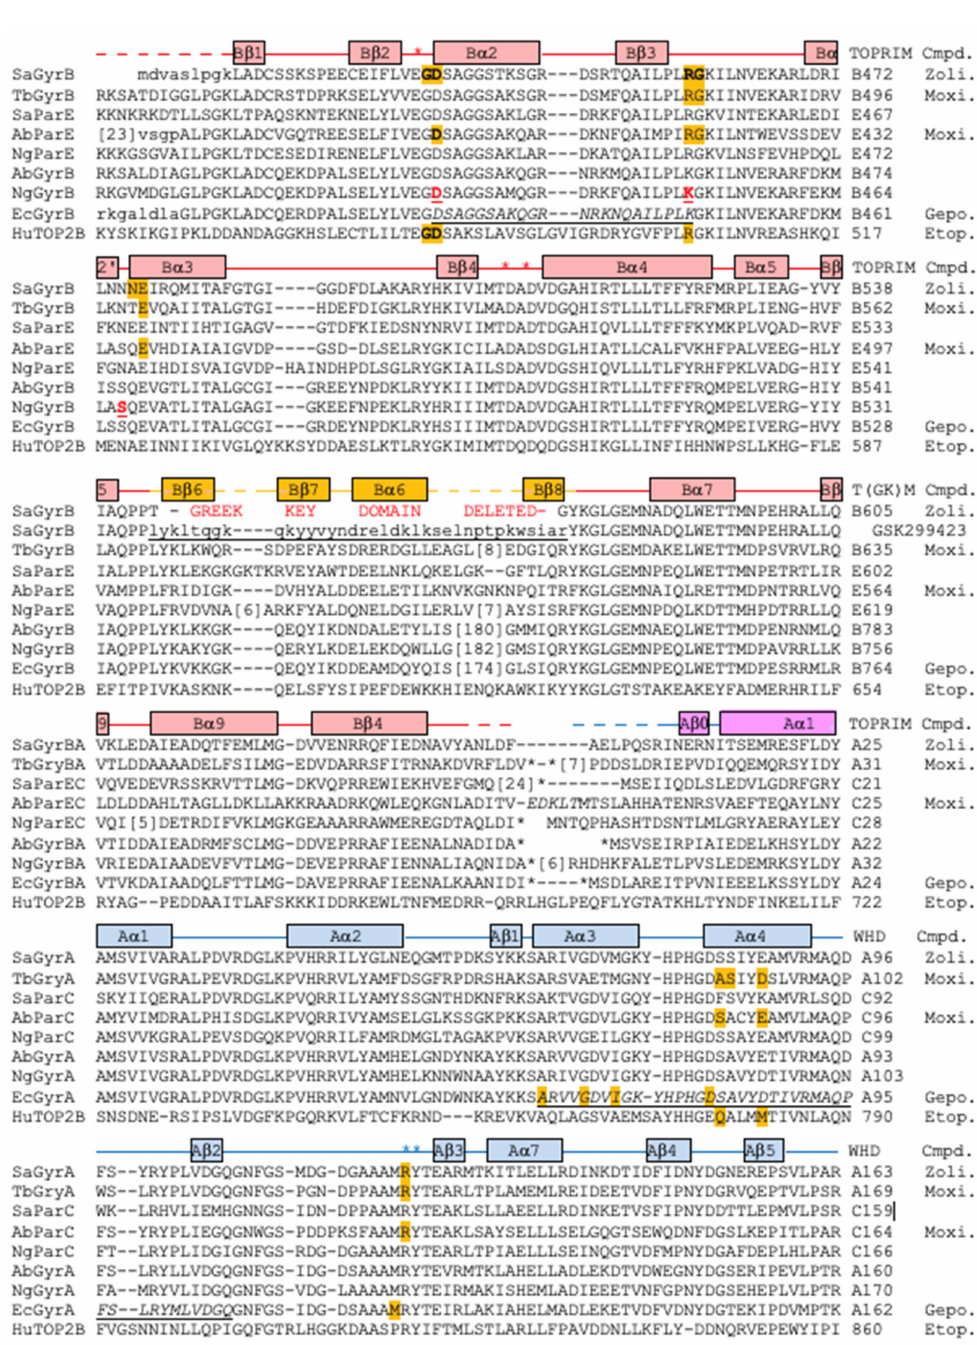
Figure 5. Sequence alignment highlighting residues contacting zoliflodacin, moxifloxacin, gepoti- dacin, or etoposide. An alignment of the residues in the TOPRIM, Greek key, and WHD domains of S. aureus GyrB/GyrA (SaGyrBA), M. tuberculosis GyrB/GyrA (TbGYRba), S. aureus ParE/ParC (SaParEC), A. baumannii ParE/ParC (AbParEC), N. gonorrhoeae ParE/ParC (NgParEC), A. baumannii GyrB/GyrA (AbGyrBA), N. gonorrhoeae GyrB/GyrA (NgGyrBA), E. coli GyrB/GyrA (EcGyrBA), and human Top2B (HuTOP2B). Numbers in brackets (e.g., [180]) show numbers of residues not included in the alignment; note the large insertion within the Greek key domain in Gram-negative DNA gyrase sequences. The three N. gonorrhoeae GyrB residues whose mutations give low levels of resistance are highlighted in red [48]. Amino acids are highlighted on sequences if they contact (<3.8 Å) compounds in S. aureus DNA gyrase structures with compounds. Zoli. = contacts in the 2.8